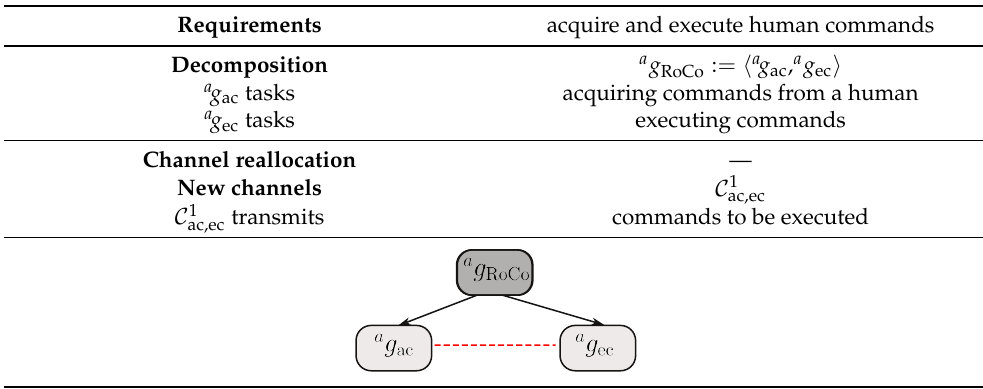
Table 1. Summary of the first step of a g RoCo decomposition process. The arrows show which groups are the result of the decomposition of the initial group. Dashed lines show emerging communication channels. The light coloured groups form the decomposition tree fringe, which shows which groups exist at the current step—the dark ones disappear, because they were